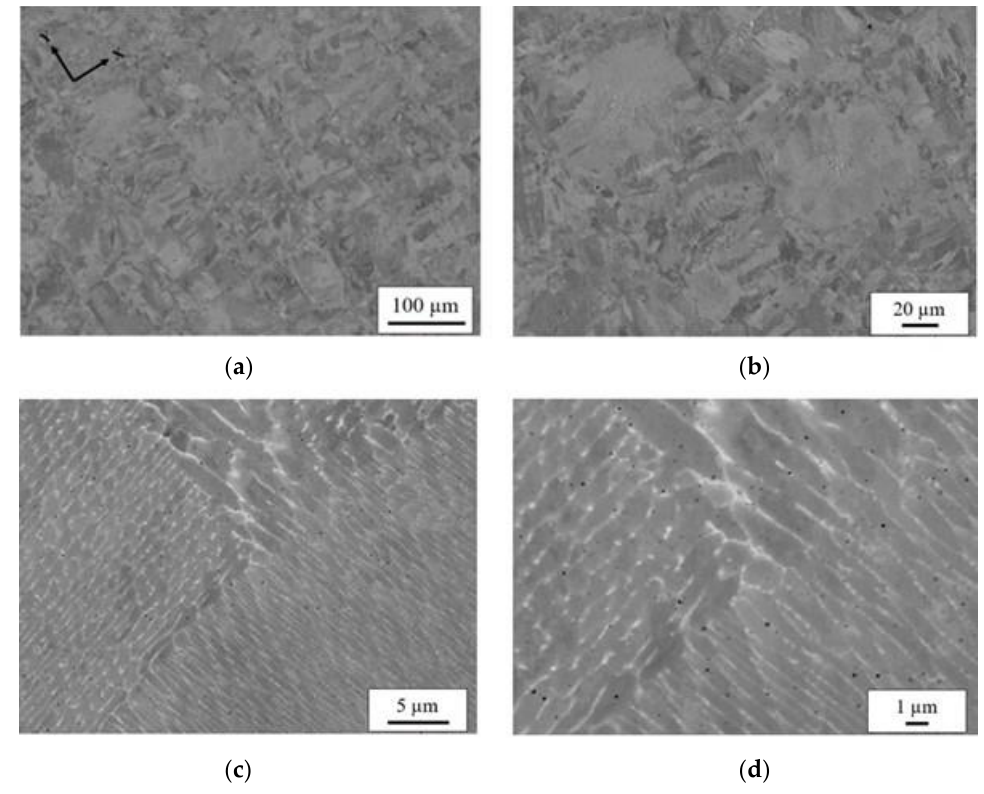
Figure 2. SEM BSE imaging of the XY build plane microstructure of the as-build specimen at increasing magnifications in a through d. Images in ( a , b ) display orientation contrasts due to electron channeling. The bright regions in the higher resolved images in ( c , d ) correspond to Nb enrichment, as indicated by periodic number contrast.